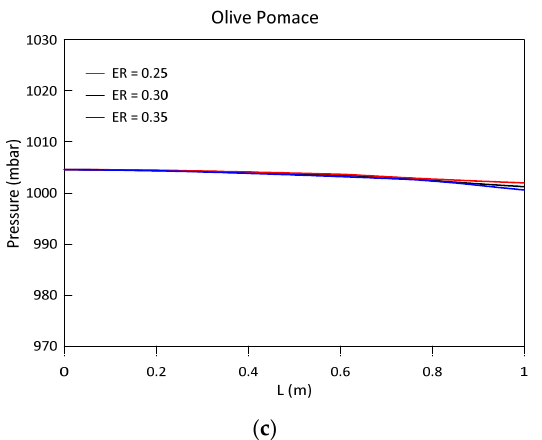
Figure 10. Pressure evolution along the reactor axis at different ER for ( a ) woodchip case 1, ( b ) hydro-char from green waste, ( c ) olive pomace.